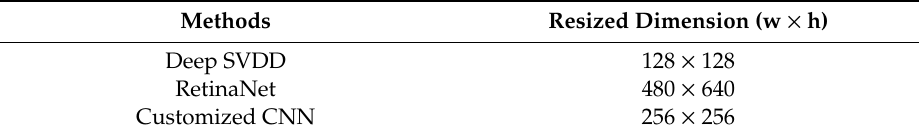
Table 2. Input image dimensions for all the three architectures